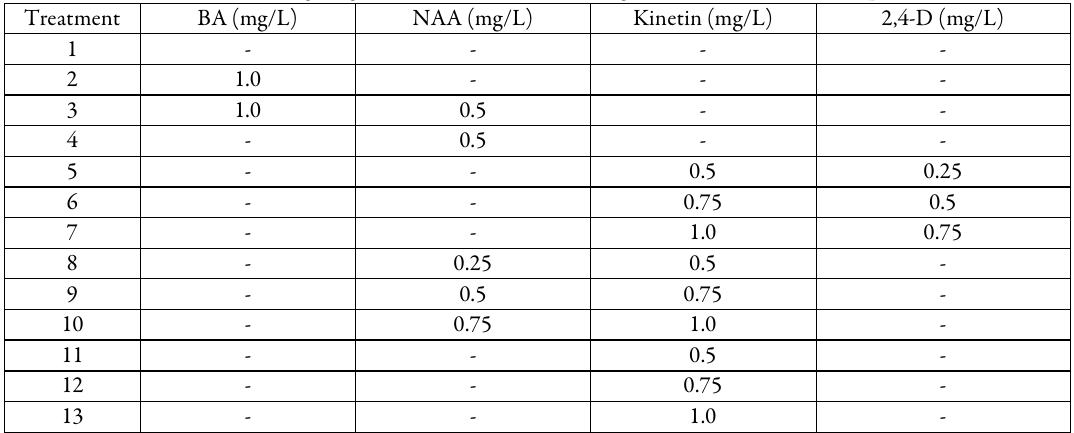
Table 1. Concentrations and combinations of BA, NAA, kinetin and 2,4-D used as supplements in MS medium for investigating callus induction and shoot regeneration from P. erosus